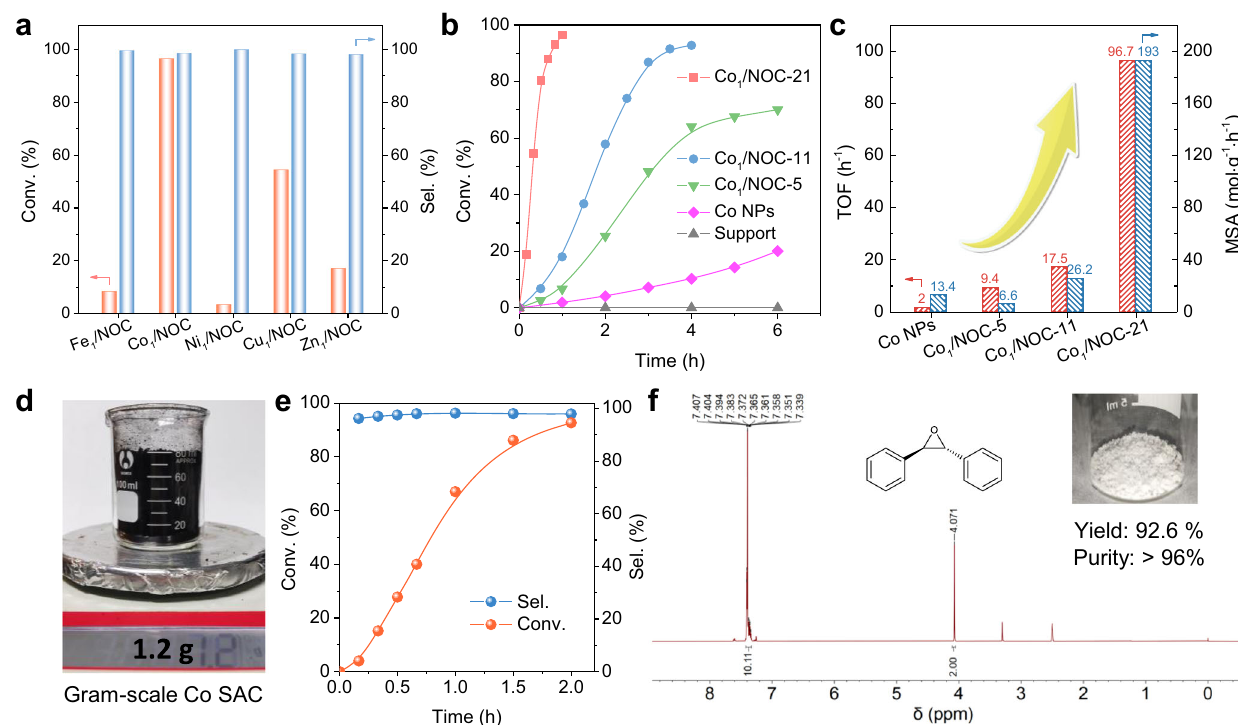
c TOF and mass-speci fi c activity (MSA) of various Co 1 /NOC samples. d Optical photo of as-prepared gram-scale Co SAC sample. e The dynamics plots of SB conversionagainstreactiontimeovergram-scaleCoSACsample. f 1 HNMRspectra of generated SBO. (400MHz, D 6 -DMSO) δ 7.34 – 7.40 (m, 10H), 4.07 (s, 2H). Inset: molecular structure and optical photo of product